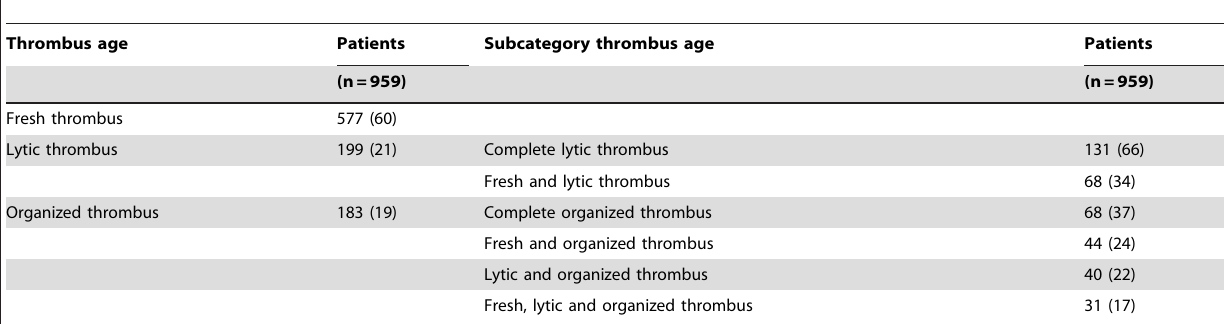
Table 2. Classification of thrombus age of aspirated material in 959 patients with classifiable thrombus material.